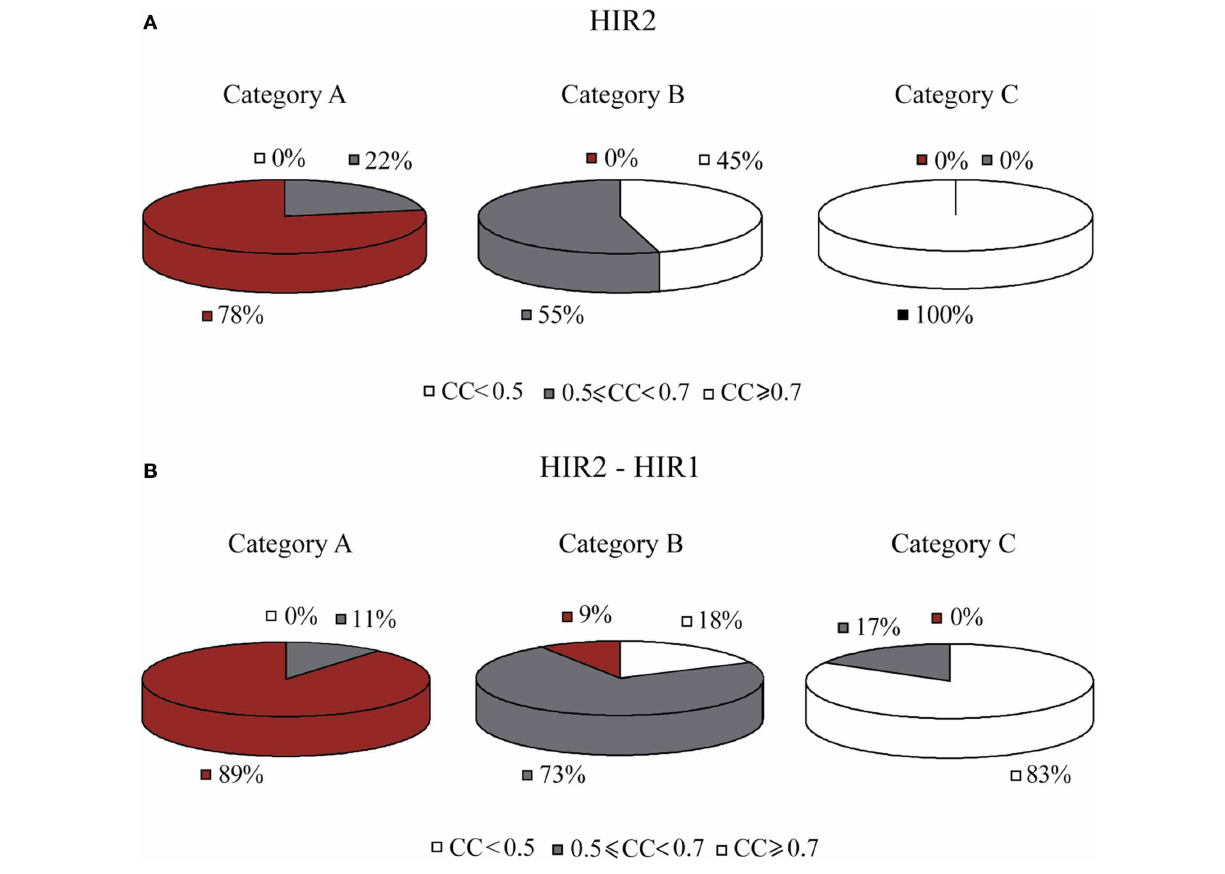
particular, the correlation coefficient for all genes is very low (CC < 0.5). (B) Results correspond to genes in modules regulated by HIR2 and HIR1. In this case the ANN performance is slightly improved in all three